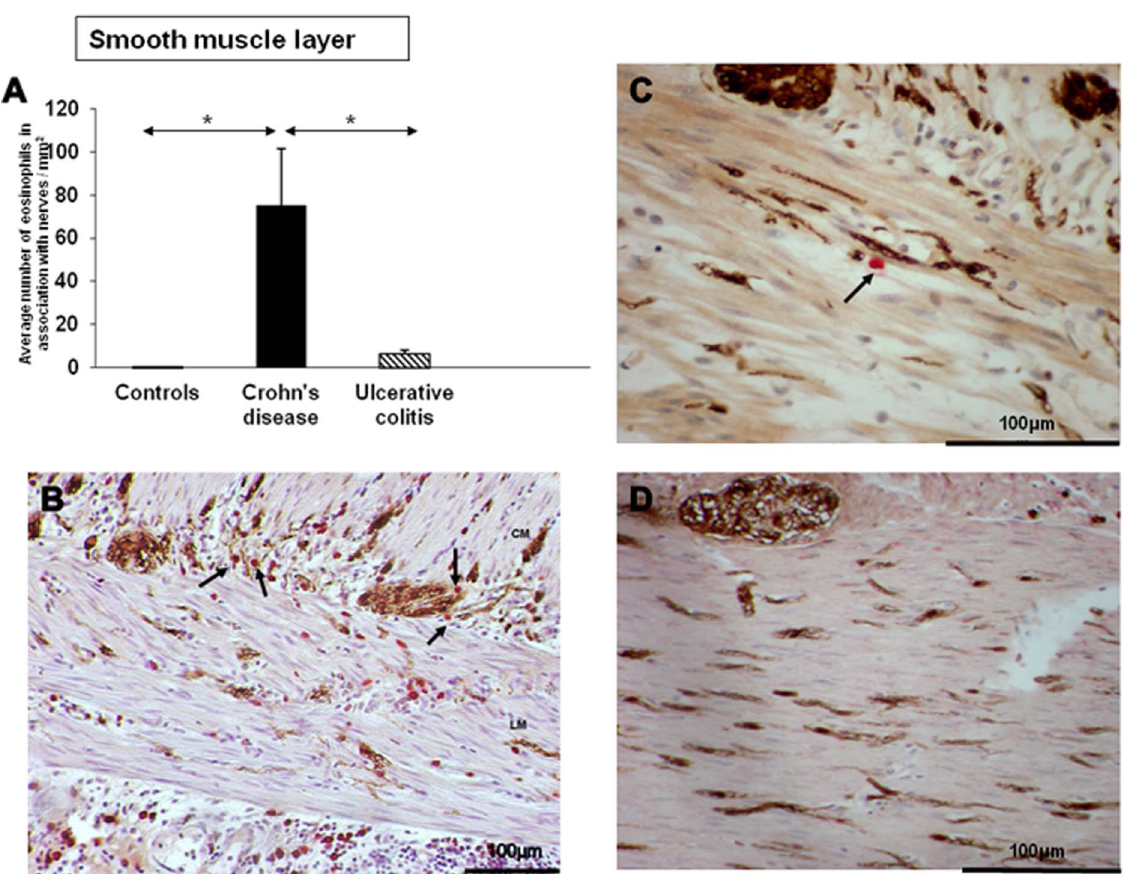
Figure 3. Eosinophils localize to the muscle layer in IBD and specifically to nerves in CD. The graph (A) shows the total number of eosinophil per mm 2 localizing to nerves in the muscle layer of patients with refractory IBD. The data are from 8 control patients, 8 patients with CD and 7 with UC. Values are mean 6 SEM, * p , 0.05. The photomicrograph shown in (B) shows eosinophil localization to nerves in the smooth muscle layer of patients with refractory CD. Photomicrograph (C) demonstrates neuroeosinophilic association in closer detail. Photomicrograph (D) shows a section from a control patient. The arrows in (B,C) demonstrate MBP stained eosinophils in contact or in close association with S100 stained nerves.